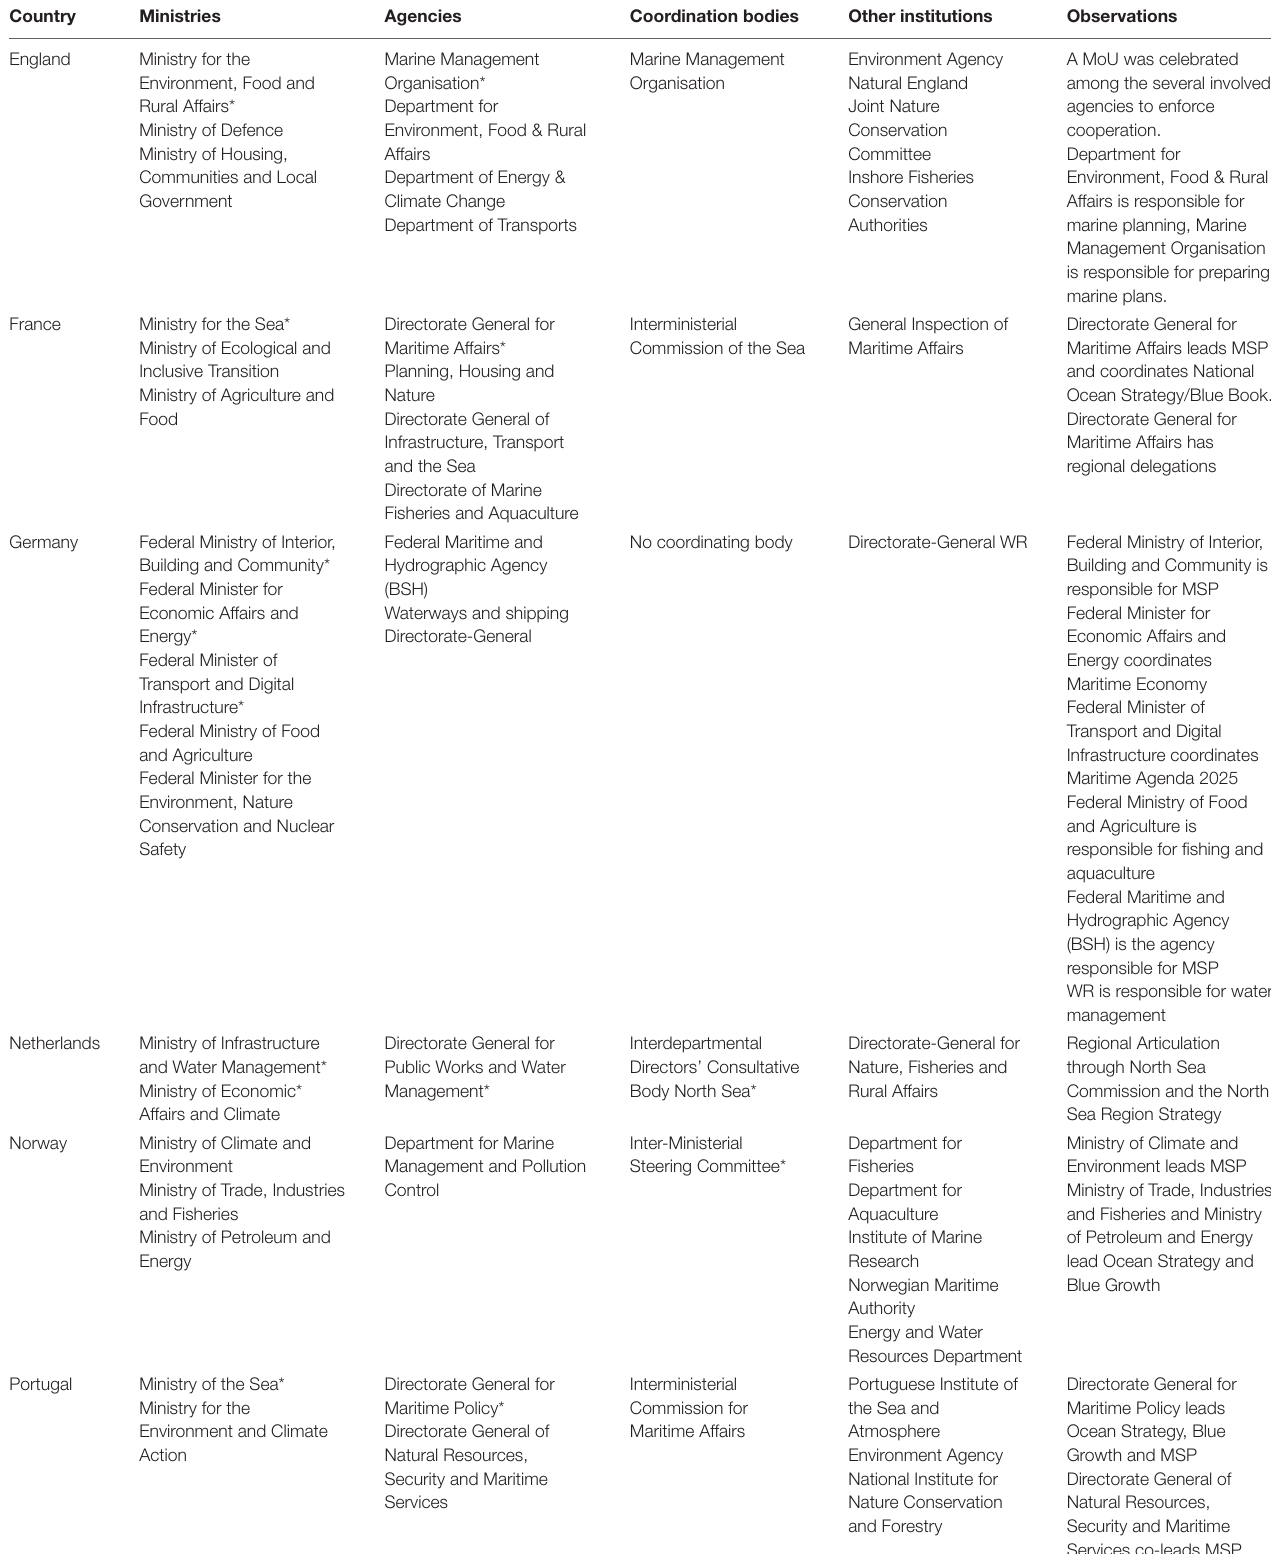
TABLE 1 | Institutional framework for maritime space governance in European case